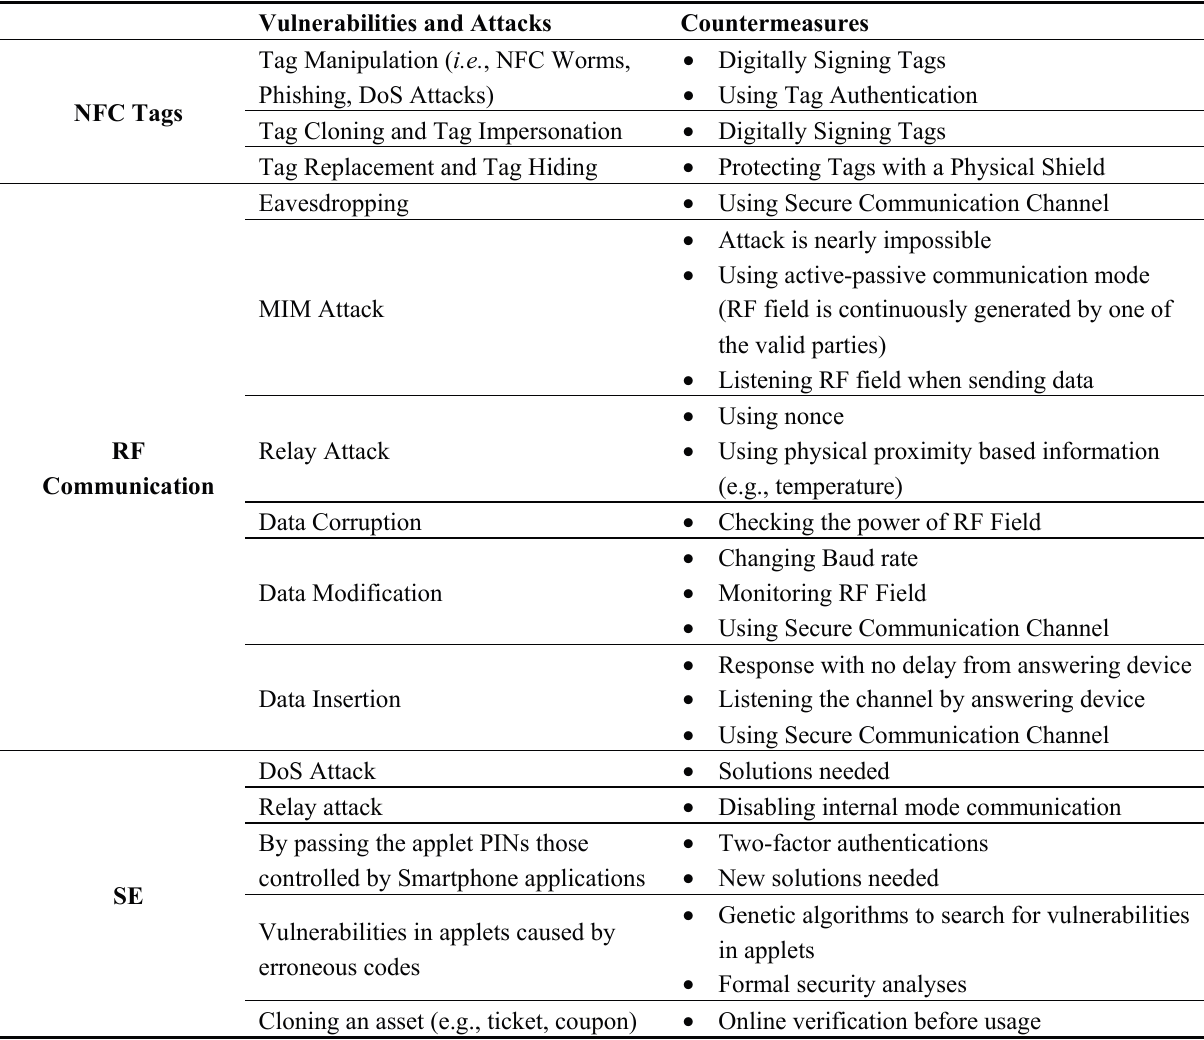
Table 1. Vulnerabilities, attacks and